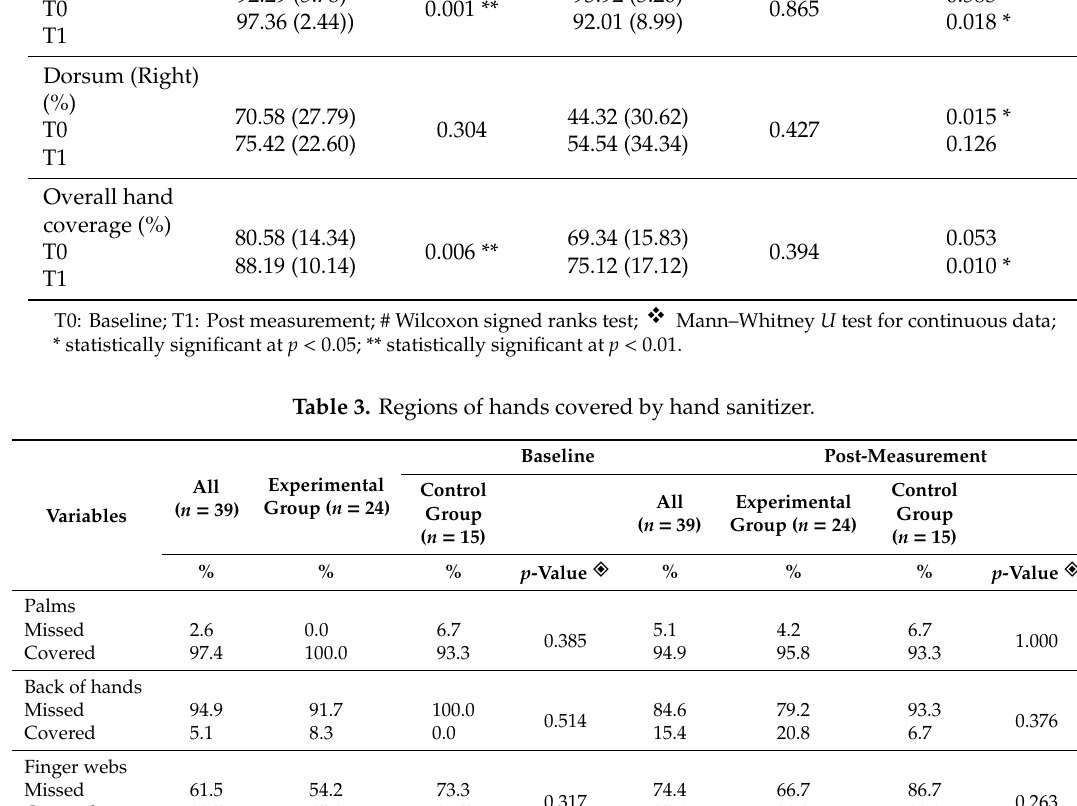
Table 2. Within-group and between-group comparisons of hand coverage (%) using hand sanitizer.